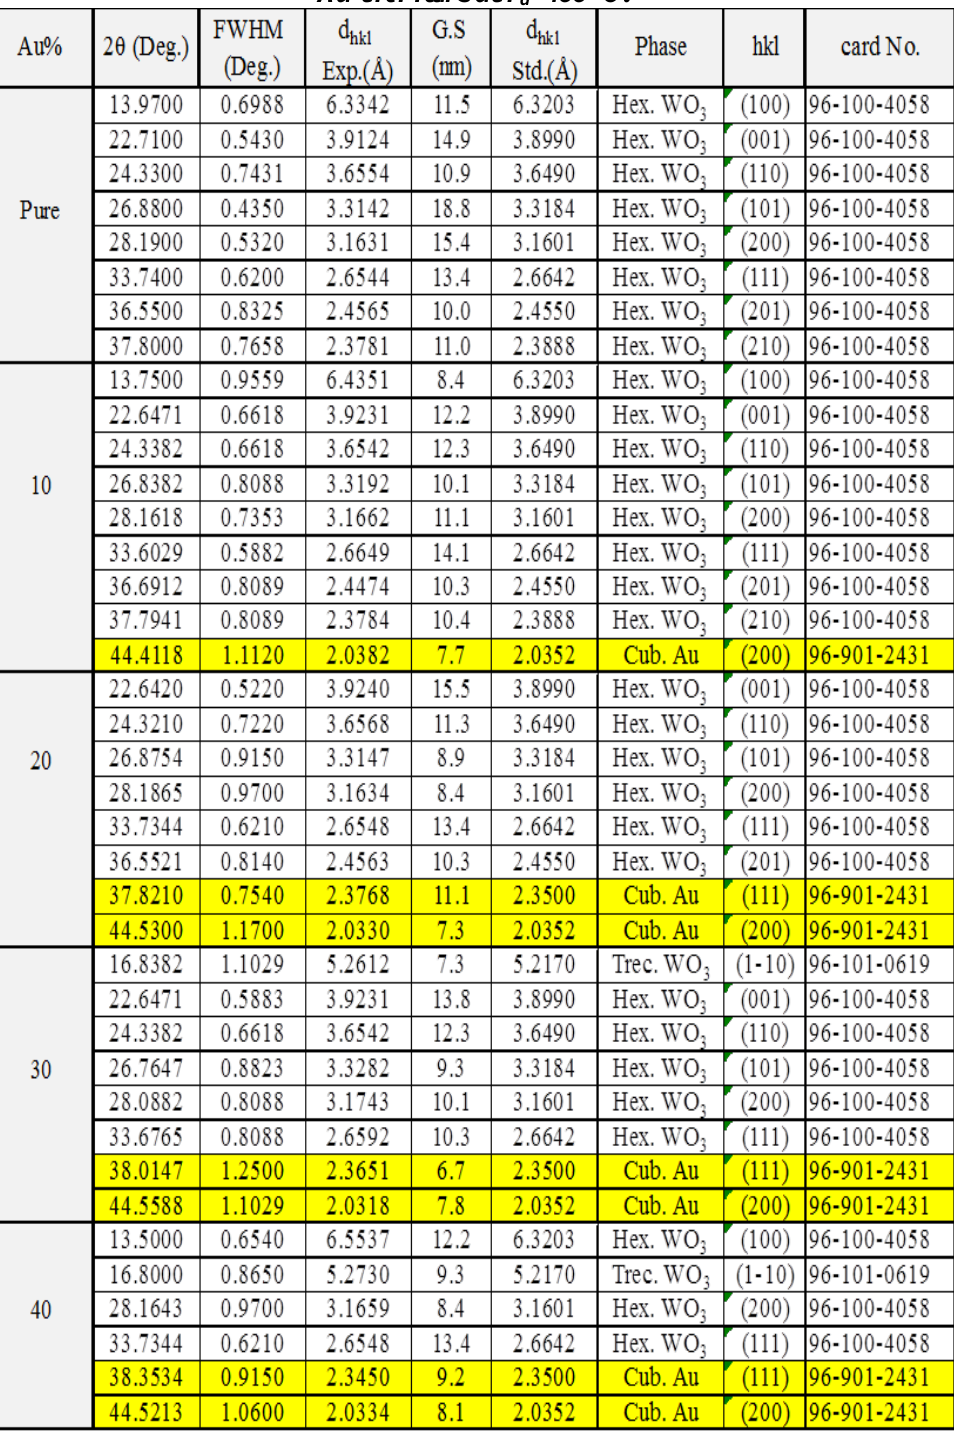
Table 1: Structural parameters vis. inter-planar spacing, crystalline size for pure WO